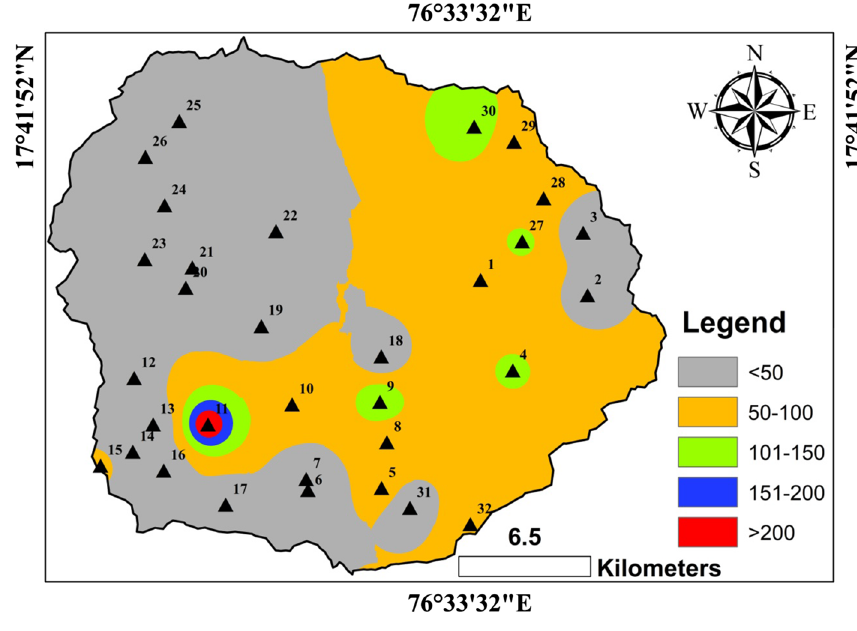
Fig. 9 Geospatial distribution of calcium